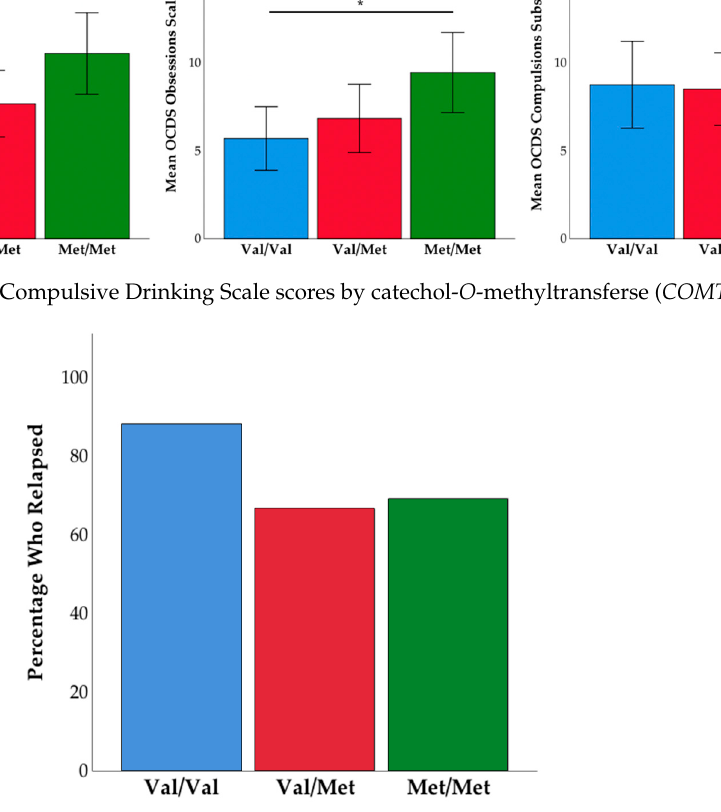
Figure 3. Percentage of individuals who had relapsed by six months post-treatment by COMT genotype.